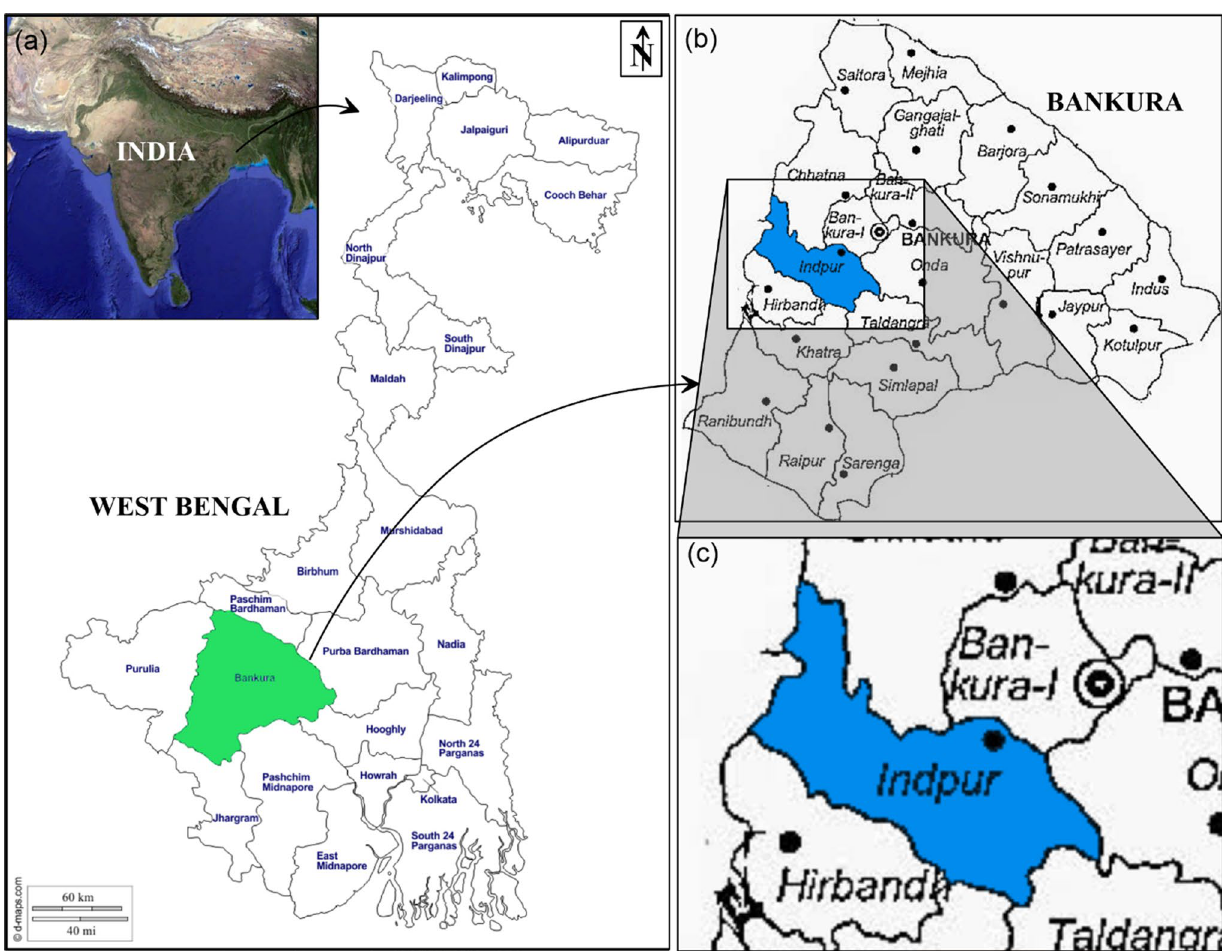
Fig. 1 Study area—Indpur block, Bankura district, West Bengal,